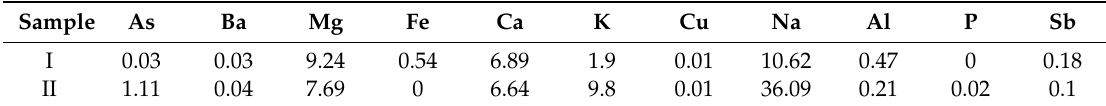
Table 5. Elemental analysis in actual water samples (mg · L − 1 ).